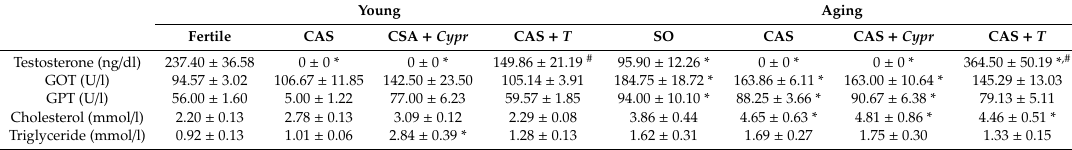
Table 2. Changes in the serum levels of testosterone (expressed as: ng / dL), glutamic oxaloacetic transaminase (GOT: expressed as U / L), glutamic-pyruvic transaminase (GPT: expressed as (U / L), cholesterol (expressed as mmol / L), and triglyceride (expressed as mmol / L). The results are shown as the means ± S.E.M. n = 4–10. * p < 0.05: Statistical significance relative to the Young / SO fertile group, # p < 0.05: Statistical significance between age-matched CAS and CAS + T groups, CAS = surgical castration, T = testosterone replacement therapy, Cypr = cyproterone acetate treatment, and SO = sham